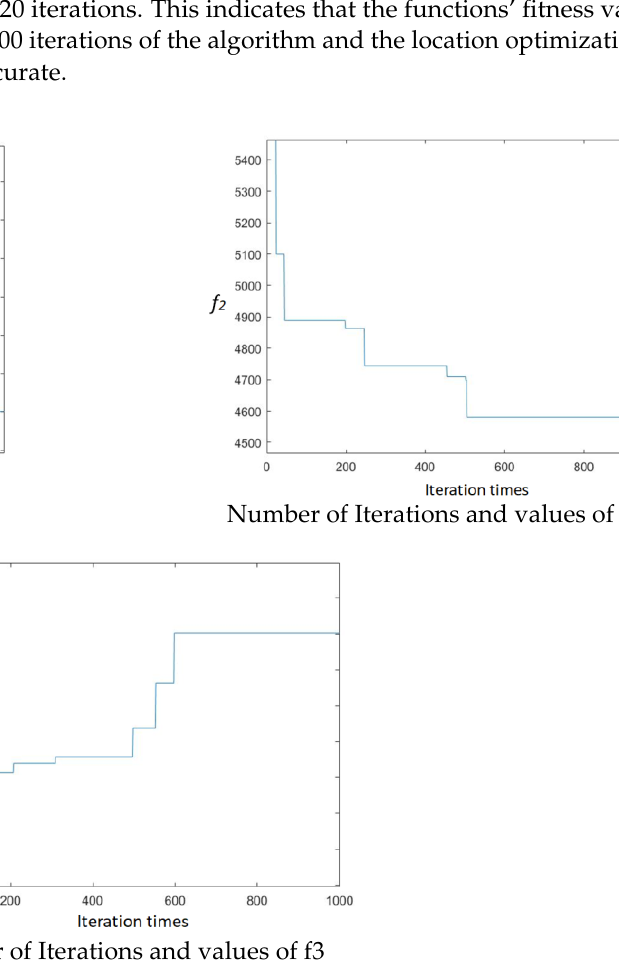
Figure 4. The fitness values of existing configuration and Pareto optimal solutions .